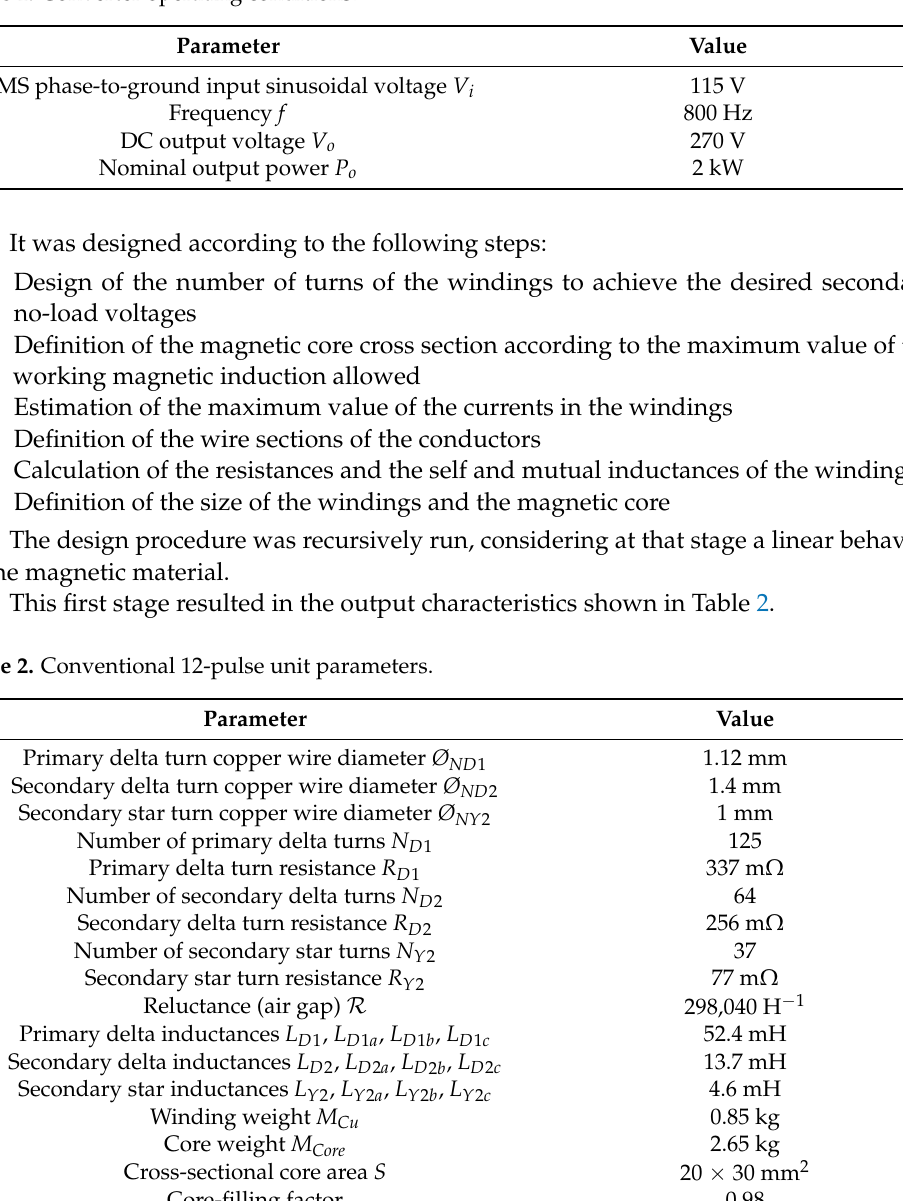
Table 1. Converter operating conditions.